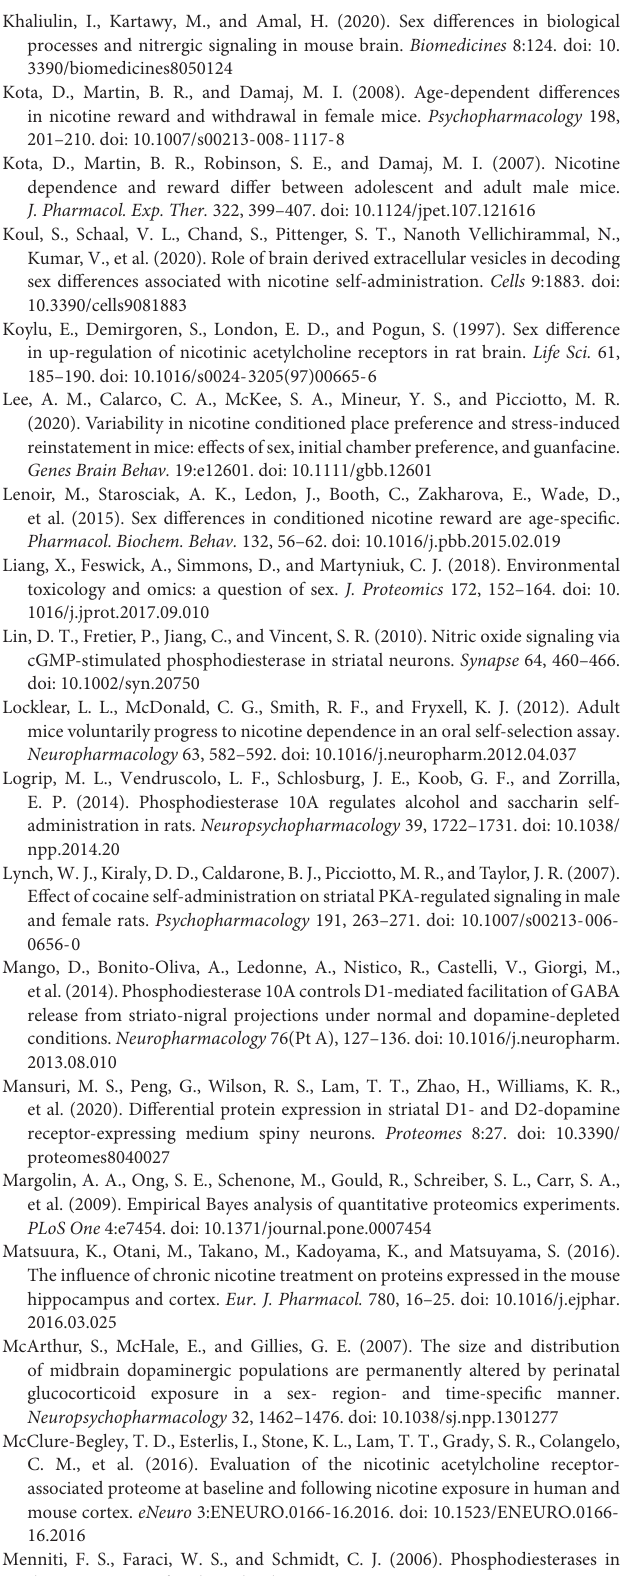
3:a012112. doi: 10.1101/cshperspect.a012112 Pichler, P., Kocher, T., Holzmann, J., Mazanek, M., Taus, T., Ammerer, G., et